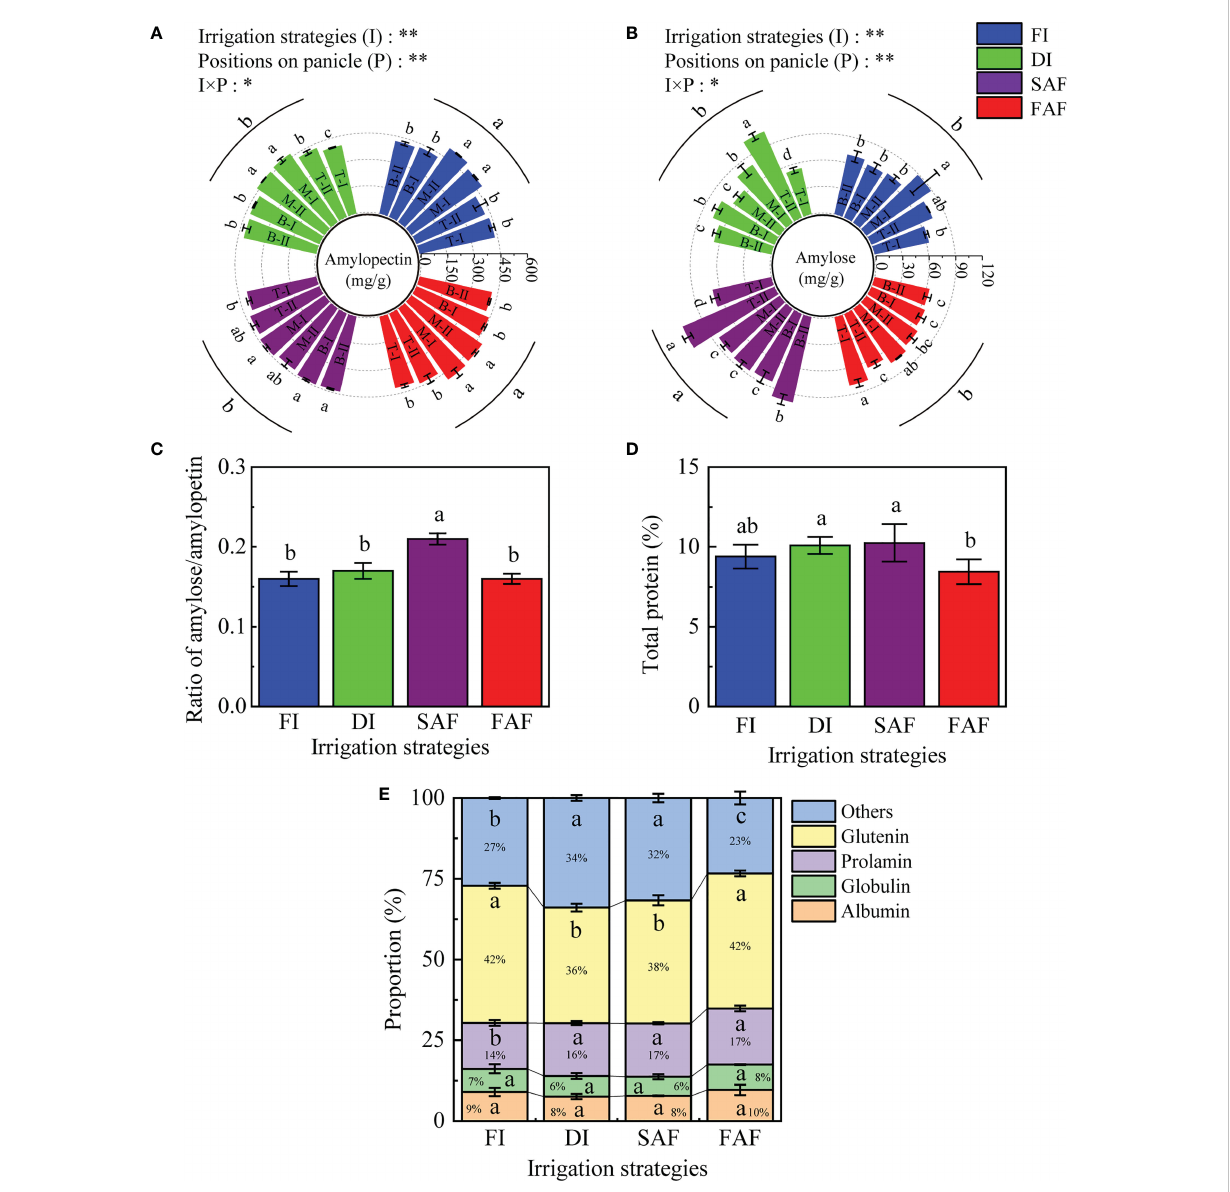
FIGURE 6 Amylopectin content (A) and amylose content (B) in grains on different positions of panicles in four water strategy management; The ratio of amylose content/amylopectin content (C) ; Total protein content in grains (D) and proportion of protein components to total protein content (E) . The vertical line on the column represents three repeated standard errors. Different letters represent signi fi cant difference among treatments (P< 0.05). The Least-Signi fi cant Difference Test (LSD) was used for comparison. ANOVA of treatment (T) and positions of panicle (P) and their interaction (T × P) (**P< 0.01; *P< 0.05). FI, the whole growing season fl ooding; DI, the whole growing season normal drip irrigation (soil relative moisture (RSM) was maintained in a range of 90 – 100%); SAF, pre-anthesis normal drip irrigation and post-anthesis water stress (the RSM was maintained in a range of 80 – 90% after anthesis); FAF, pre-anthesis normal drip irrigation and post-anthesis fl ooding; T, M and B represent the top, middle and bottom of the panicles respectively, and the Roman numerals I and II represent the primary and secondary branches